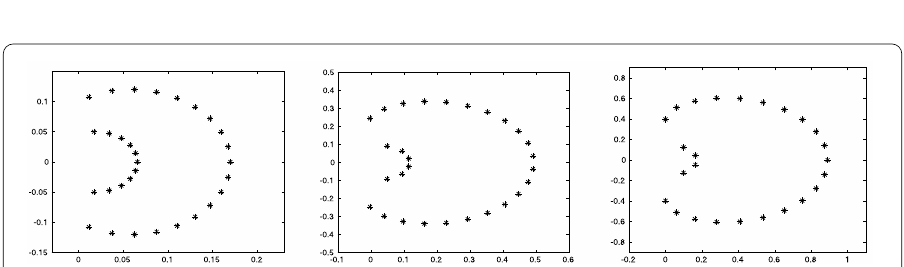
Figure 18 Eigenvalues of U n in the case of the ( N + 1)-block-discrete Hahn weight functions with ( N , n ) = (2,30),(6,28),(10,25) (from left to right)